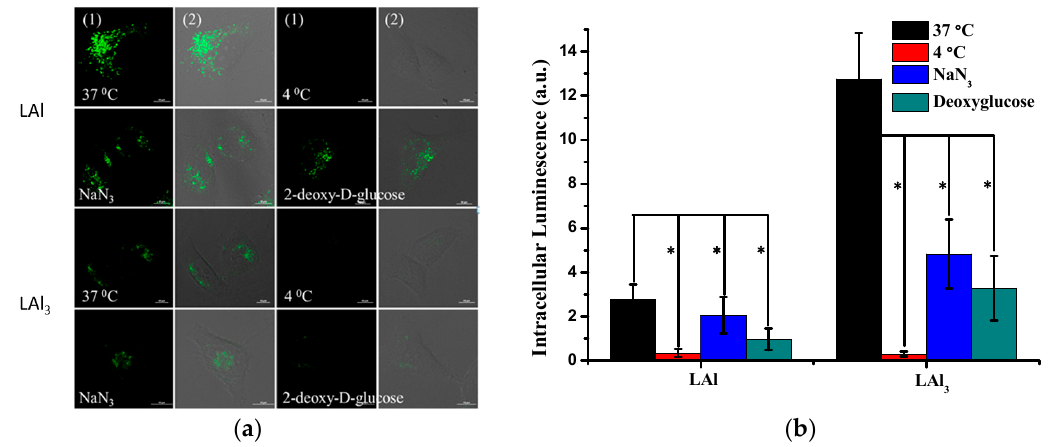
Figure 6. Cellular uptake of LAl and LAl 3 inhibited at 4 °C and by depletion of cellular ATP in HeLa cells. ( a ) Imaging of LAl and LAl 3 which were incubated for 30 min at 37 °C or at 4 °C or after depletion of the cellular ATP pool by 10 mM NaN 3 or 6 mM 2-deoxy- D -glucose. (1) Images of the two compounds at the same experimental conditions. (2) Merged images of (1) and Differential interference contrast (DIC). ( b ) Uptake is expressed as the median of cell fluorescence. Mean ± SD are indicated. Values significantly ( p < 0.005) ( n = 30) different from control (internalization at 37 °C) are marked with asterisk. For depletion of cellular ATP pool, cells were preincubated for 1 h with 10 mM sodium azide and 6 mM 2-deoxy- D -glucose. a.u., arbitrary unit.